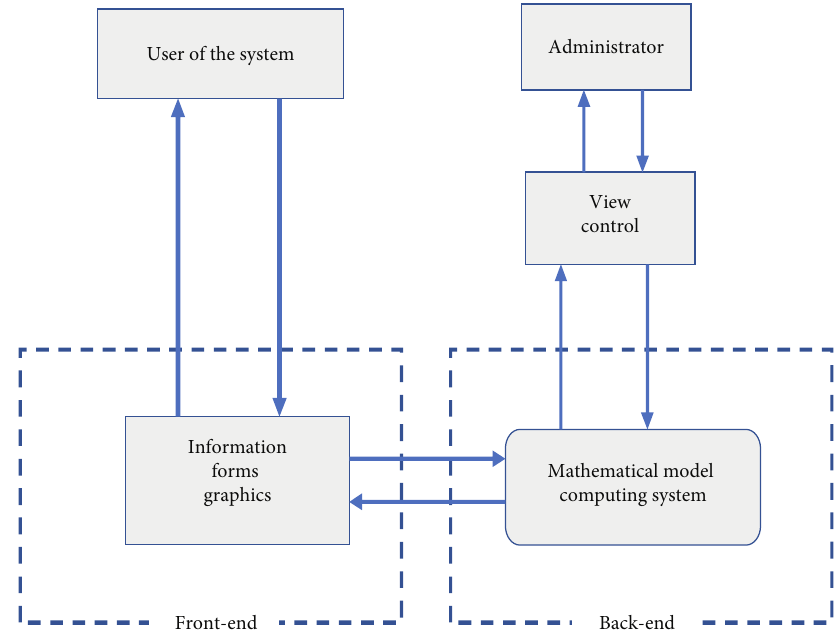
Figure 2: Context diagram of